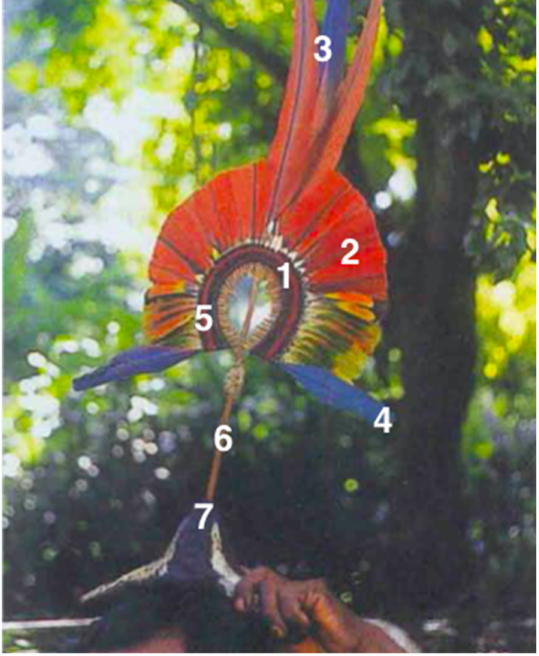
Figure 5. Mekutom ceremonial headdress and helmet. (1) The arch that supports the feathers represents the layers of the upper world (pykra). (2) The feathers red macaw, blue macaw and parrot feathers represent the face of the sun. (3) The three most elongated central feathers are the nose and the eyes of the sun. (4) The more elongated feathers on the sides portray the ears of the sun. (5) The path of the sun in this world is represented by the red stripe, uniting the east and the west. (6) The rod symbolizes the cord used by ancestors to descend into this world. (7) The helmet framed with beeswax mixed with remnants of dried vegetables is shaped like a freshwater turtle or tracaj á . The highest part of the helmet symbolizes the center of the world and the location of the first